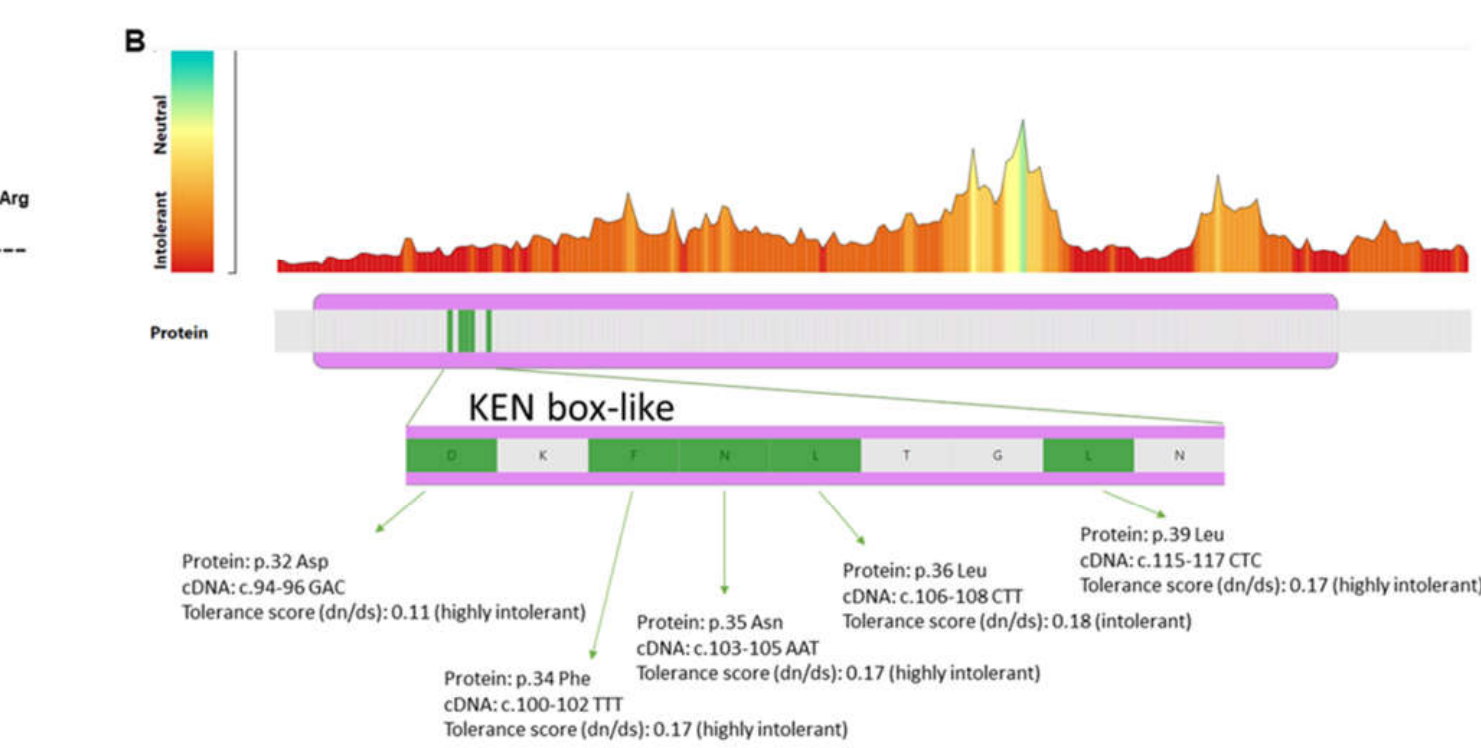
Figure 11. ( A ) Recurrent or unique missense mutations reported so far (HGMD database and current study) affecting the KEN-box-like domain (aa 32-40) of the CK2beta protein (NP_001311.3). The p.Leu39Arg identified in patient 1 is indicated in bold. ( B ) MetaDome web server for the CSNK2B gene. The tolerance landscape (upper panel) indicated the region that is intolerant to missense variation. Enlargement of the KEN box-like motif located between protein positions 32 and 40. The mutations identified in patients with IDCS or POBINDS are indicated in green. The analysis shows that these mutations are located in a region of high intolerance. The non-synonymous over-synonymous ratio, or dn/ds score, is used to quantify genetic tolerance [42].